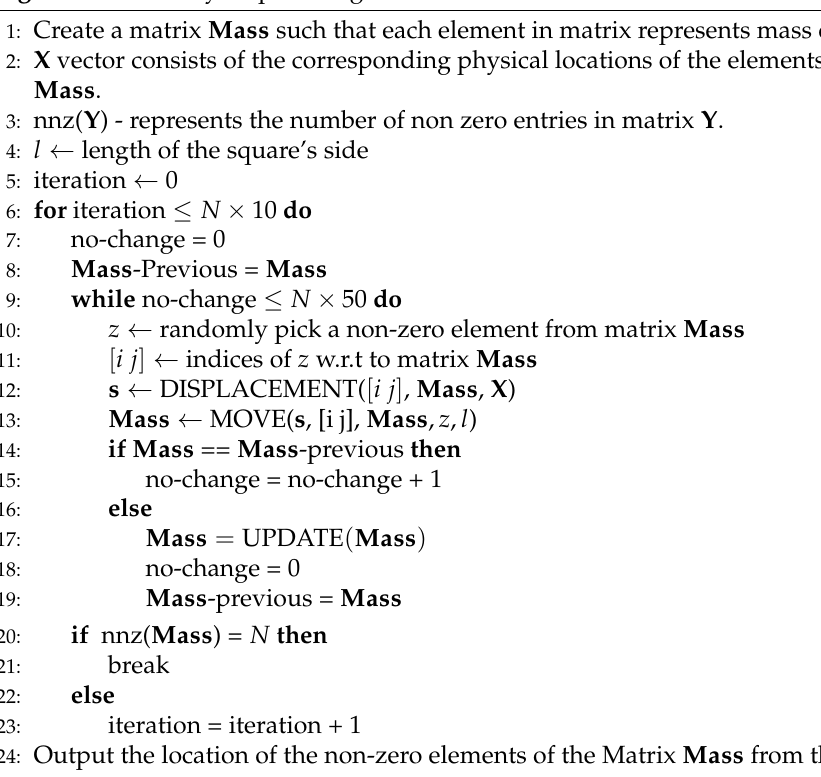
Algorithm 2 Gravity Inspired